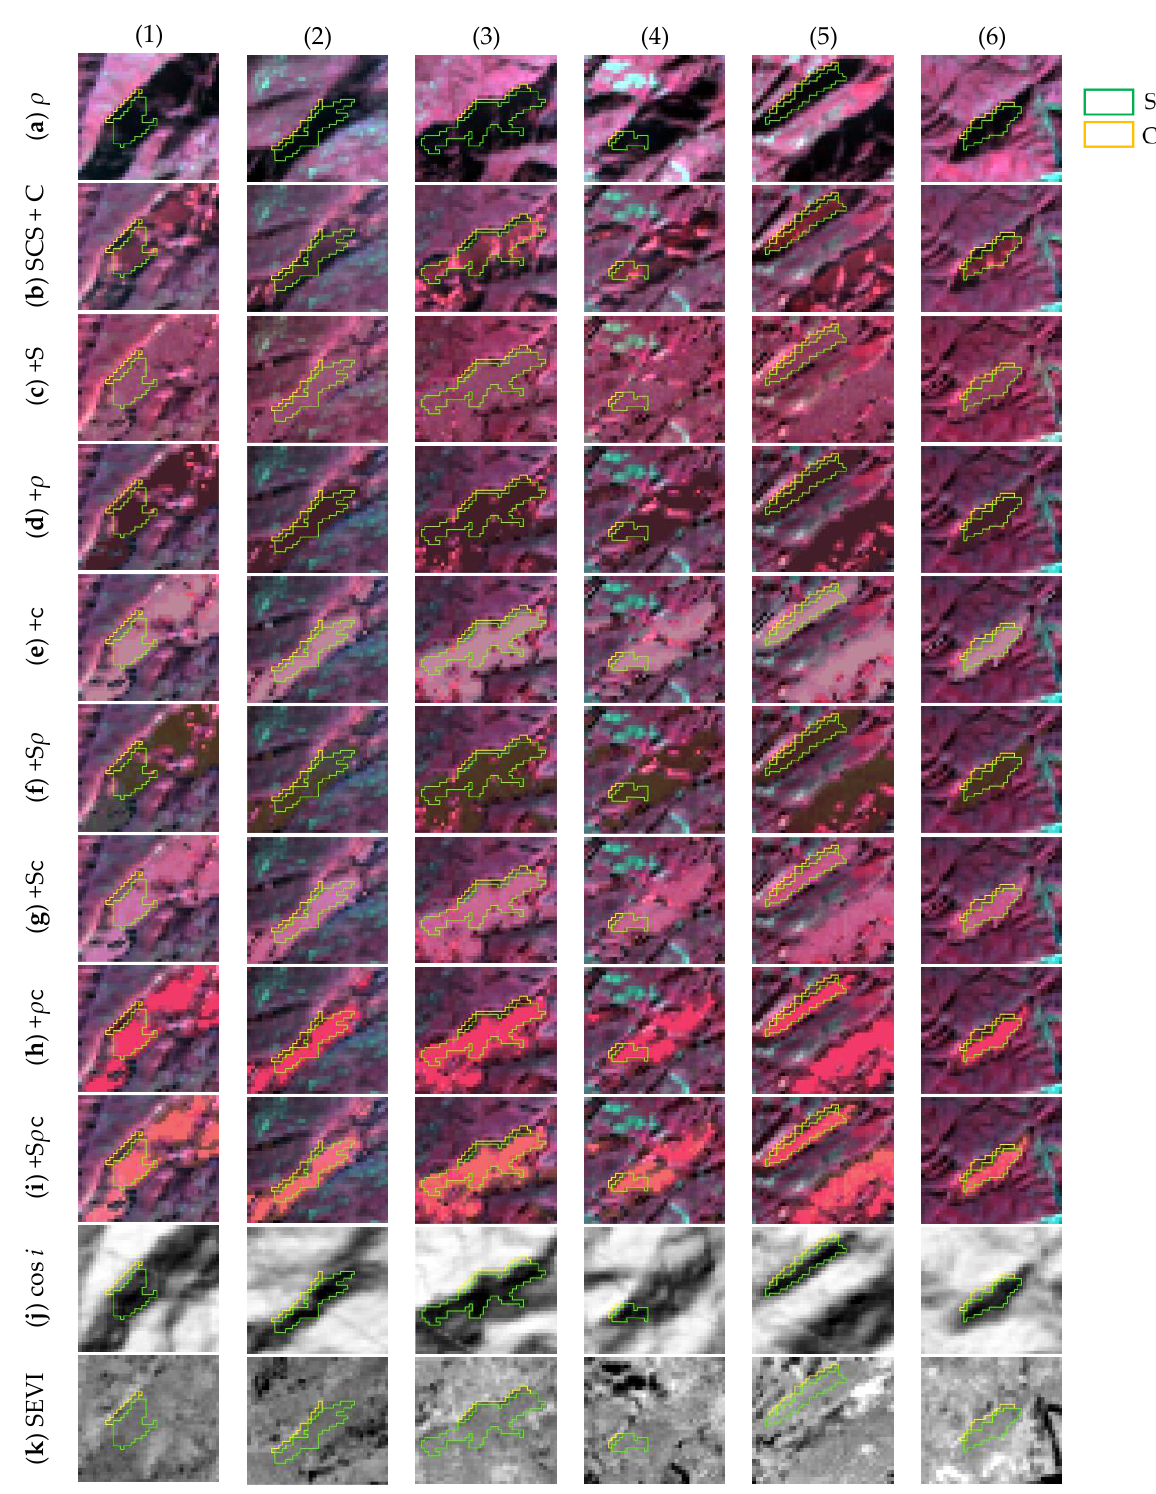
Figure 3. Sample areas of different processed images (NRG composite), cos i , and SEVI: ( a ) surface reflectance ( ρ ), ( b ) SCS + C-corrected reflectance (SCS + C), ( c ) ITC-corrected reflectance with input of SEVI (+S), ( d ) input of ρ (+ ρ ), ( e ) input of cos i (+c), ( f ) inputs of SEVI + ρ (+S ρ ), ( g ) inputs of SEVI + cos i (+Sc), ( h ) inputs of ρ + cos i (+ ρ c), ( i ) inputs of SEVI + ρ + cos i (+S ρ c), ( j ) cos i , and ( k )